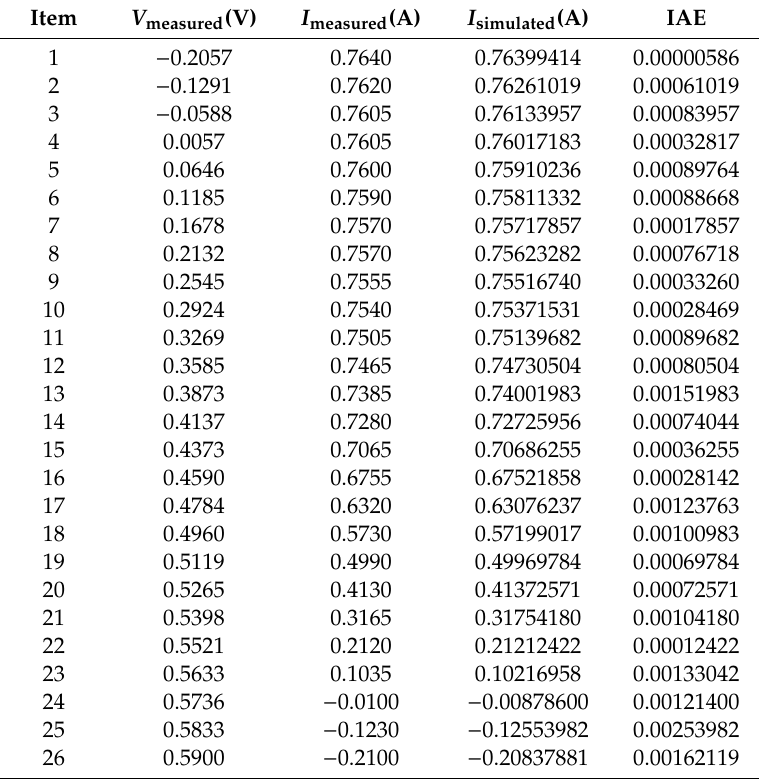
Table A3. Absolute error of IMFO for each measured on the double diode